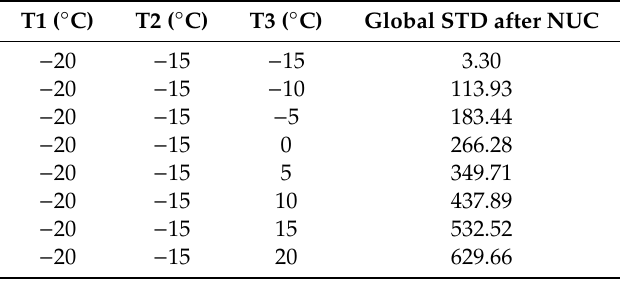
Table 2. Two-point Non-Uniformity Correction (TP NUC) statistics of experiment 1.